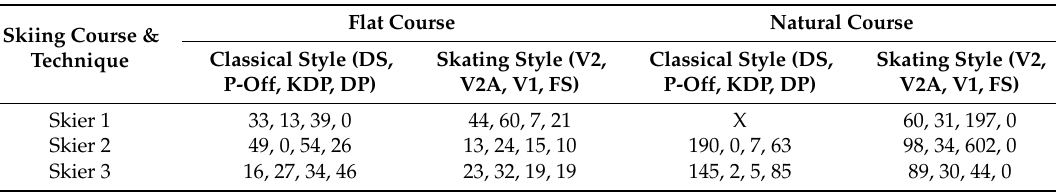
Table 5. Number of cycles of each technique for the classical and skating style performed by each skier in the validation dataset on the flat and natural course.